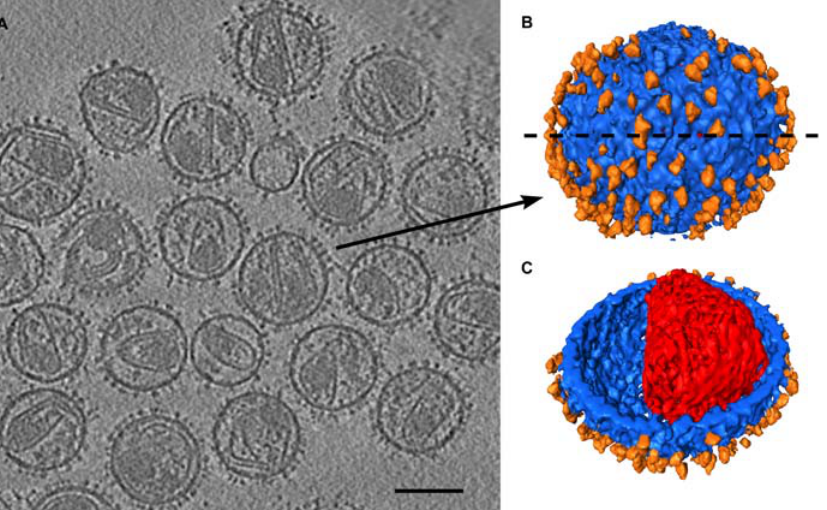
Figure 1. Three-Dimensional Reconstruction of SIV Virions from Cryo-Electron Tomography (A) A slice through the xy plane of a reconstructed tomogram from the (cid:1) 6- l m defocus dataset. The spike complexes are clearly visible on the viral surface. Some of the cores appear disrupted, reflecting AT-2 treatment. Scale bar represents 100 nm. (B) Surface rendering of one of the virions. The membrane is represented in blue, the core in red and the spikes in orange. (C) The same virus as in (B) viewed after removing half of the viral envelope along the dotted line to reveal the core. The density between the core and the membrane has not been rendered. DOI: 10.1371/journal.ppat.0020083.g001 PLoS Pathogens |